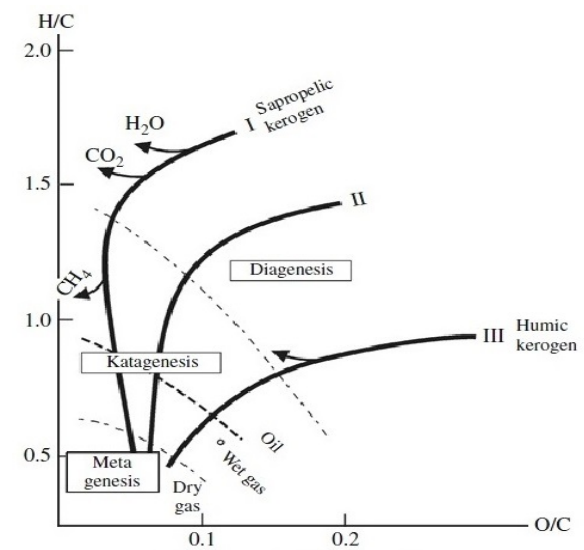
Fig.1. Van Krevelen diagram of kerogen